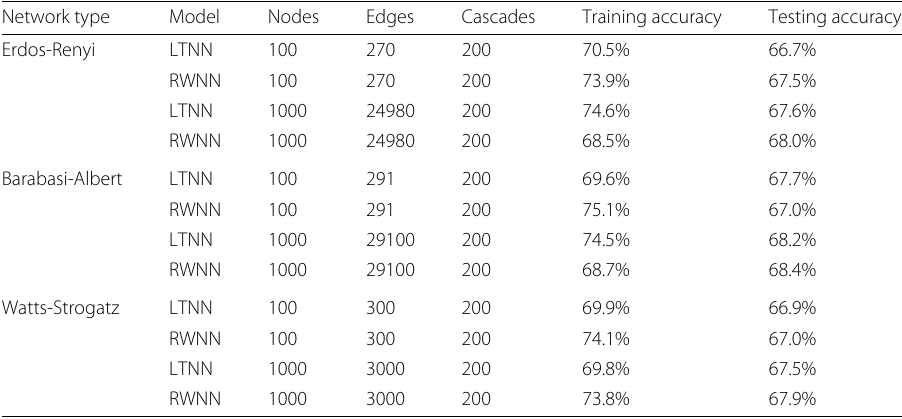
Table 2 Performance of large-scale synthetic